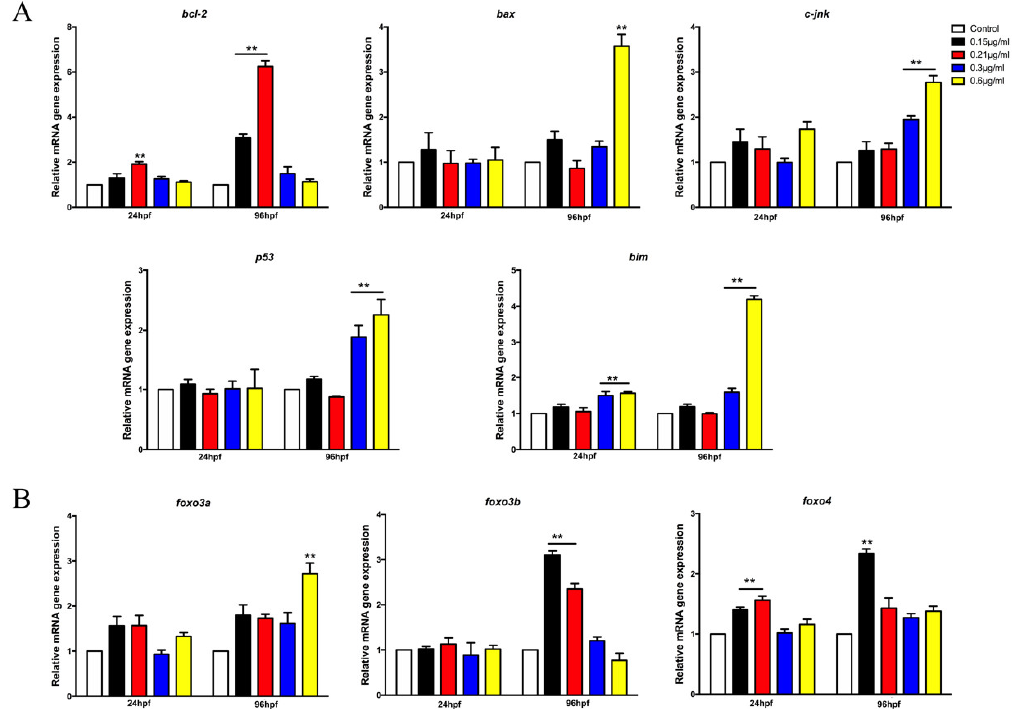
Figure 5. mRNA expression of apoptosis-related genes and regulatory genes in 24 and 96 hpf embryos after honokiol microemulsion treatment. The mRNA expression levels of antiapoptotic and proapoptotic genes are shown in ( A ). The mRNA expression levels of apoptosis regulatory FoxO subtypes are shown in ( B ). The data are expressed as the mean ± SD (** p < 0.01 compared with control).